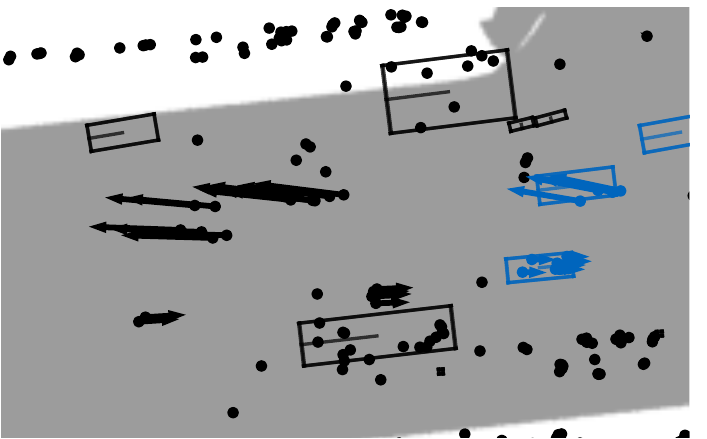
Figure 13. Moving vehicles ground-truth color-coded in blue. Ground-truth bounding boxes are not labeled for four vehicles in the sensor field of view, though they are clearly distinguishable by their relative velocity. NuScenes sample token: